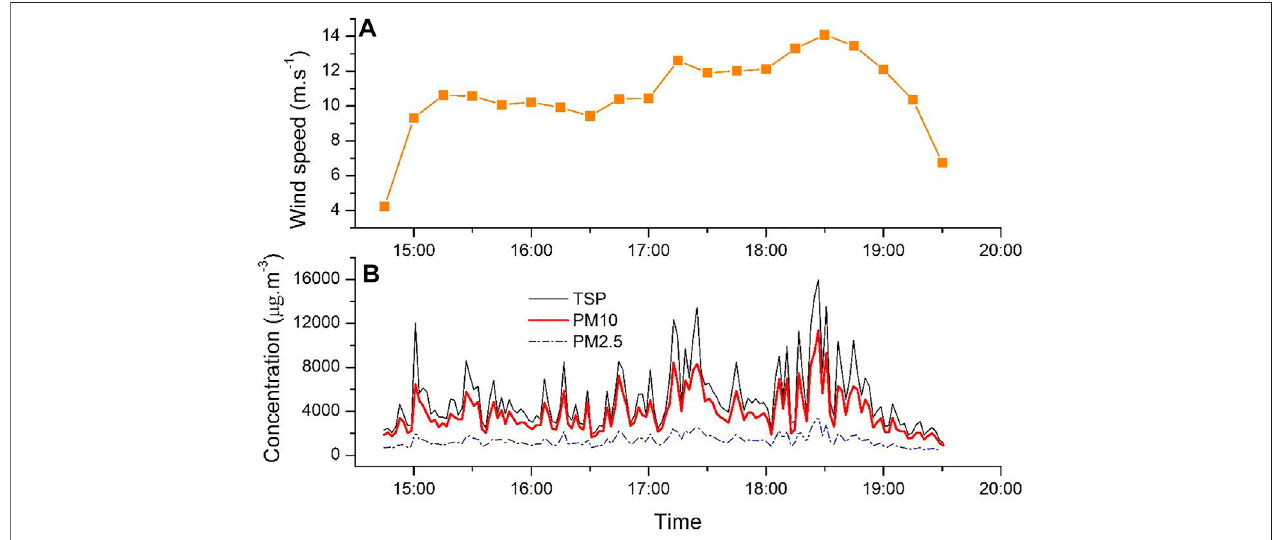
FIGURE7| Windspeedsat theheightof2 matoptheMogaoGrottoes (A) andthecorrespondingdust concentrations (B) changingwithtimeunder atypical dust storm of easterly winds on 13 March 2012.